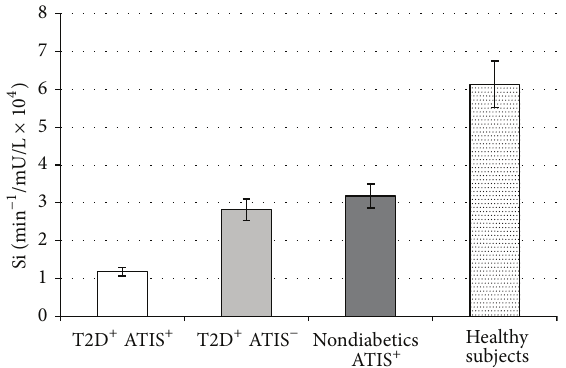
Figure 1: Values are means ± SE. Bar graphs show the values of Si determined by minimal model analysis. Si levels were significantly lower in type 2 diabetes (T2D) patients with atherothrombotic ischemic stroke (ATIS) compared to T2D patients without ATIS ( 𝑃 < 0.001 ) and in nondiabetics with ATIS compared to healthy subjects ( 𝑃 < 0.001 ). There is no difference in Si levels between T2D patients without ATIS and nondiabetics with ATIS ( 𝑃 = NS) (analysis of variance (ANOVA) with post hoc Tamhane test).